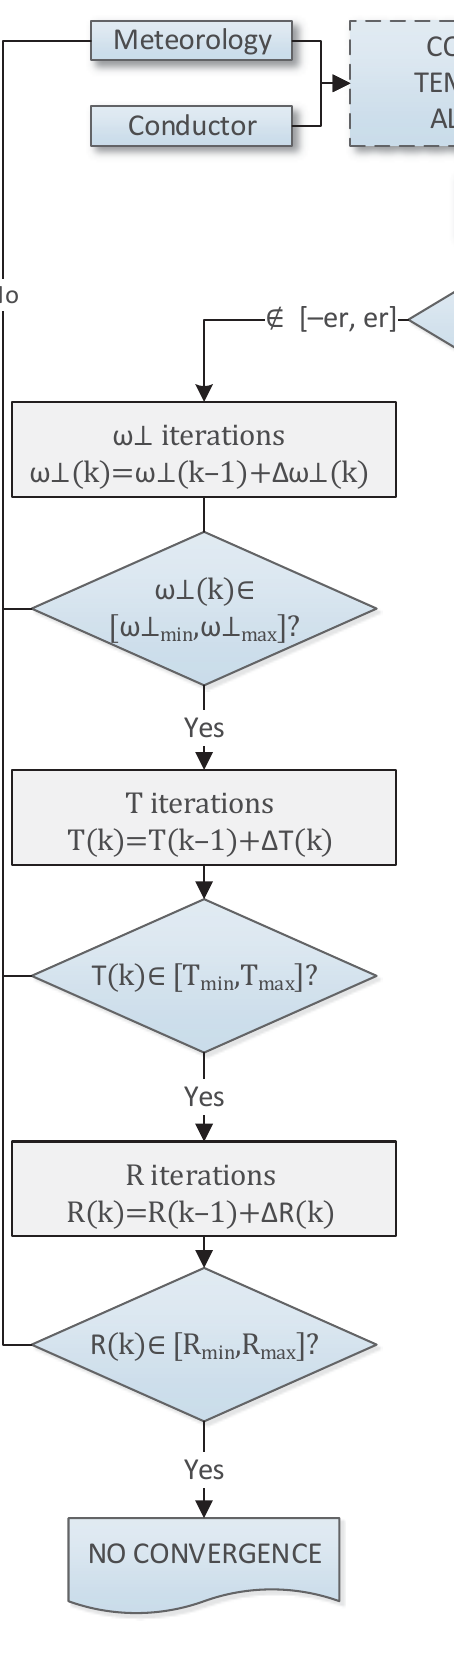
Figure 11. Iteration method flow